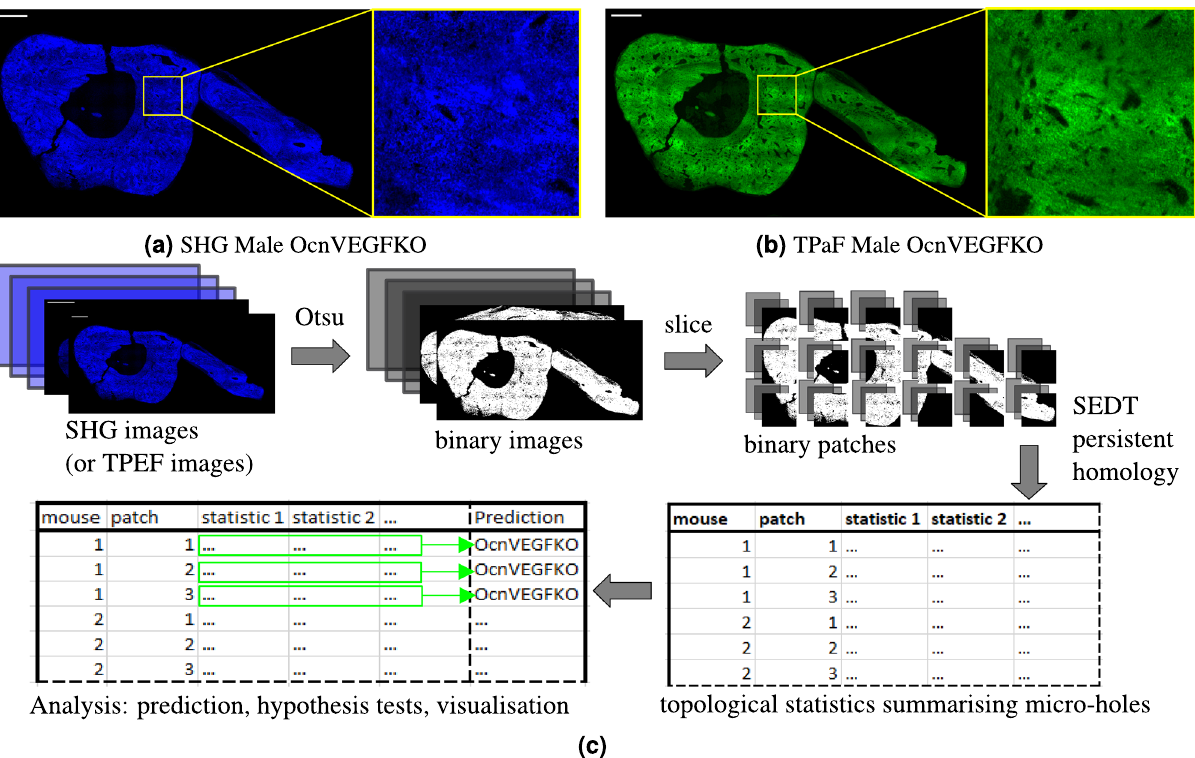
Figure 1. Non-linear microscopy images adapted from 7 and methodology schematic. Tibiofibular junction (TFJ) bone section of a male Osteocalcin-specific Vegf knockout (OcnVEGFKO) with SHG ( a ) and TPaF ( b ) images from a custom multiphoton microscope 7 , with zoomed regions. Scale bars are 250 µ m . Schematic in ( c ) gives a high level overview of the method